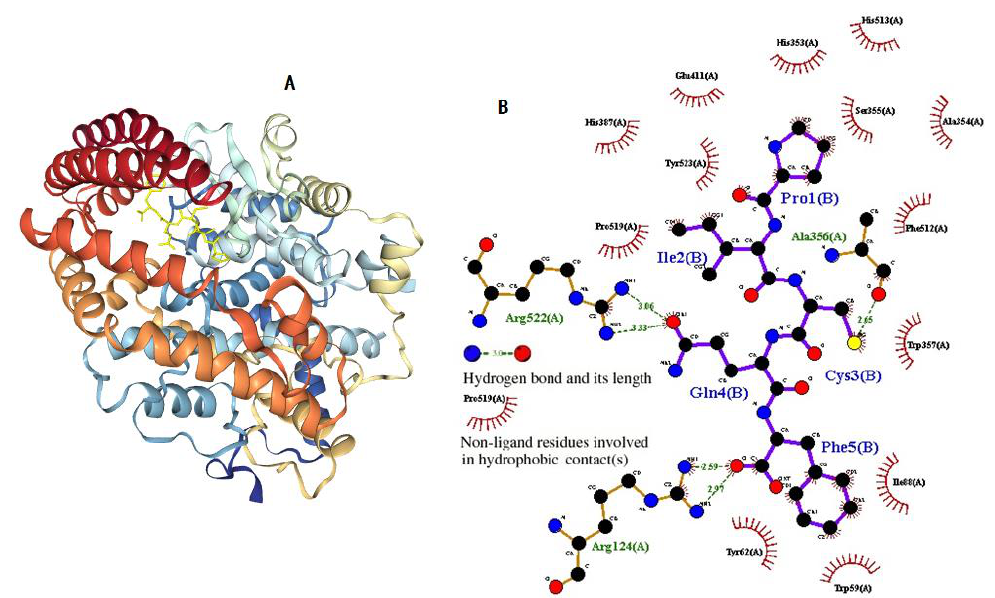
Figure 4. Binding of the representative oligopeptides to angiotensin-converting enzyme and the interacting residues, angiotensin-converting enzyme and PICQF ( A , B ). The crystal structure of angiotensin-converting enzyme (ACE) (PDB code: 2XY9) was obtained from the PDB database, which was docked to the oligopeptides generated by in silico hydrolysis using HPEPDOCK software (http://huanglab.phys.hust.edu.cn/hpepdock, accessed on 5 March